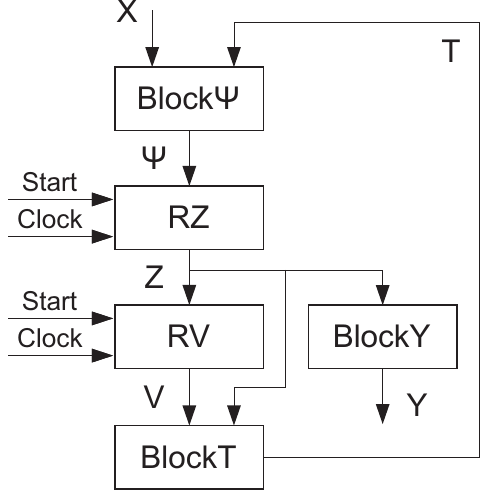
Figure 6. Structural diagram of PZ Mealy